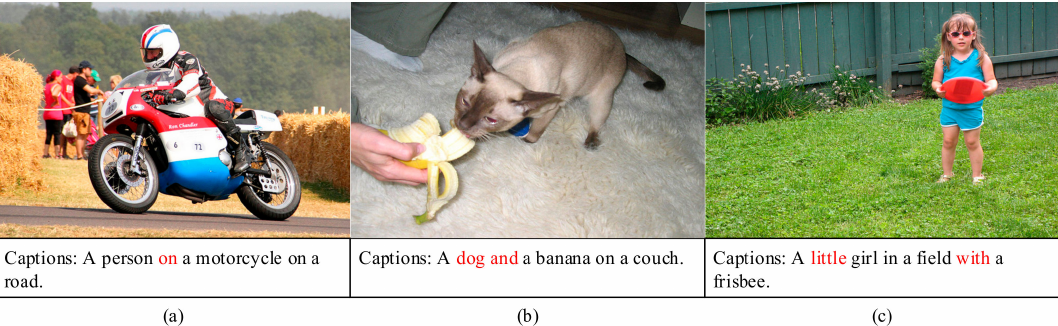
Figure 1. Illustration of some defects that attention may produce without guidance. We present some of them, such as a simplistic logical description ( a ), incorrect object recognition ( b ), and poor details of a target ( c ). The words in red are the incorrect